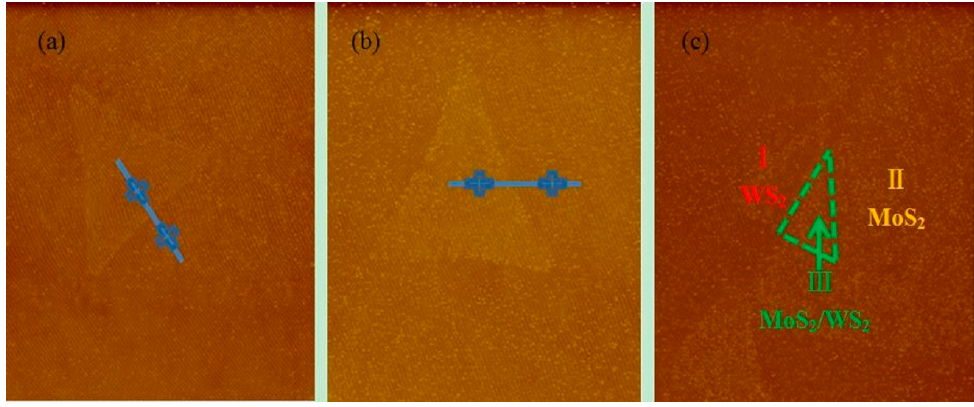
Figure 4. Atomic force microscope (AFM) image of ( a ) MoS 2 ; ( b ) WS 2 ; ( c ) MoS 2 /WS 2 vertical hetero-junction.